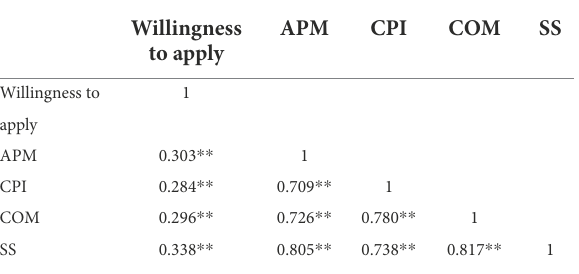
TABLE 9 Pearson’s correlation